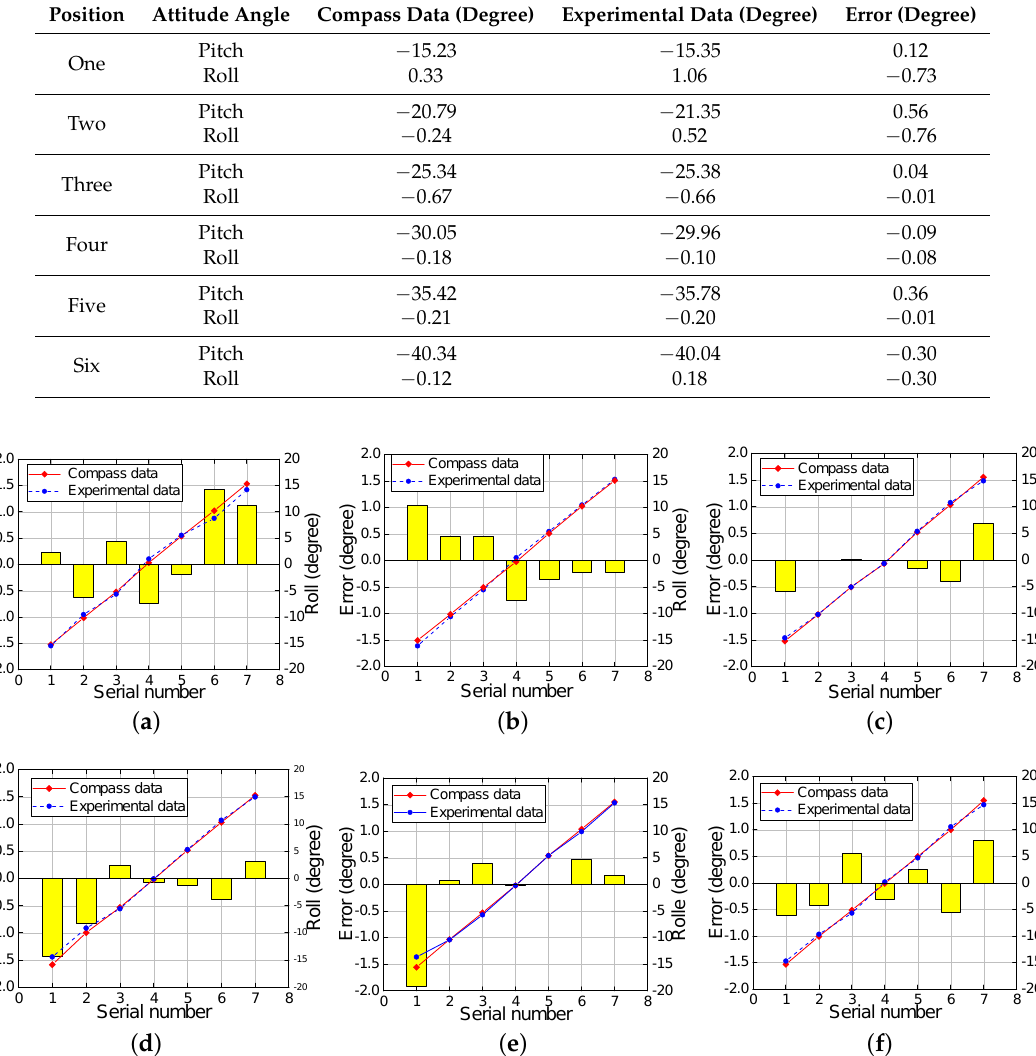
Figure 7. Roll angle comparison at pitch angles of ( a ) − 15 ◦ ; ( b ) − 20 ◦ ; ( c ) − 25 ◦ ; ( d ) − 30 ◦ ; ( e ) − 35 ◦ ; and ( f ) − 40 ◦